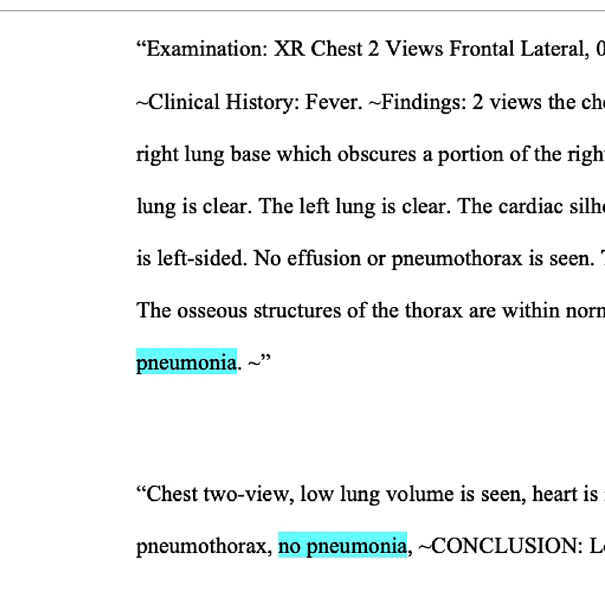
algorithm. Natural language processing (NLP), a class of machine